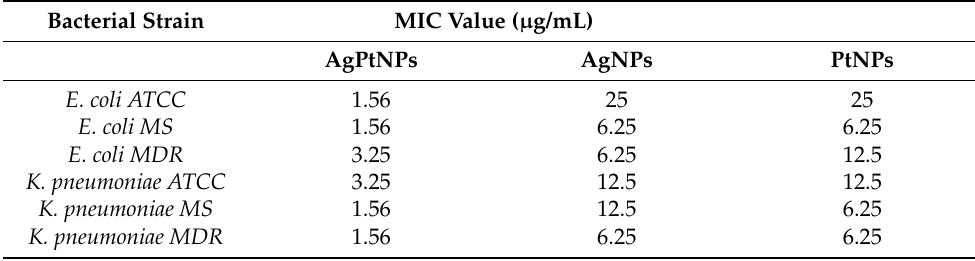
Table 5. Minimum inhibitory concentration of bimetallic and monometallic NPs against all Gram- negative bacterial